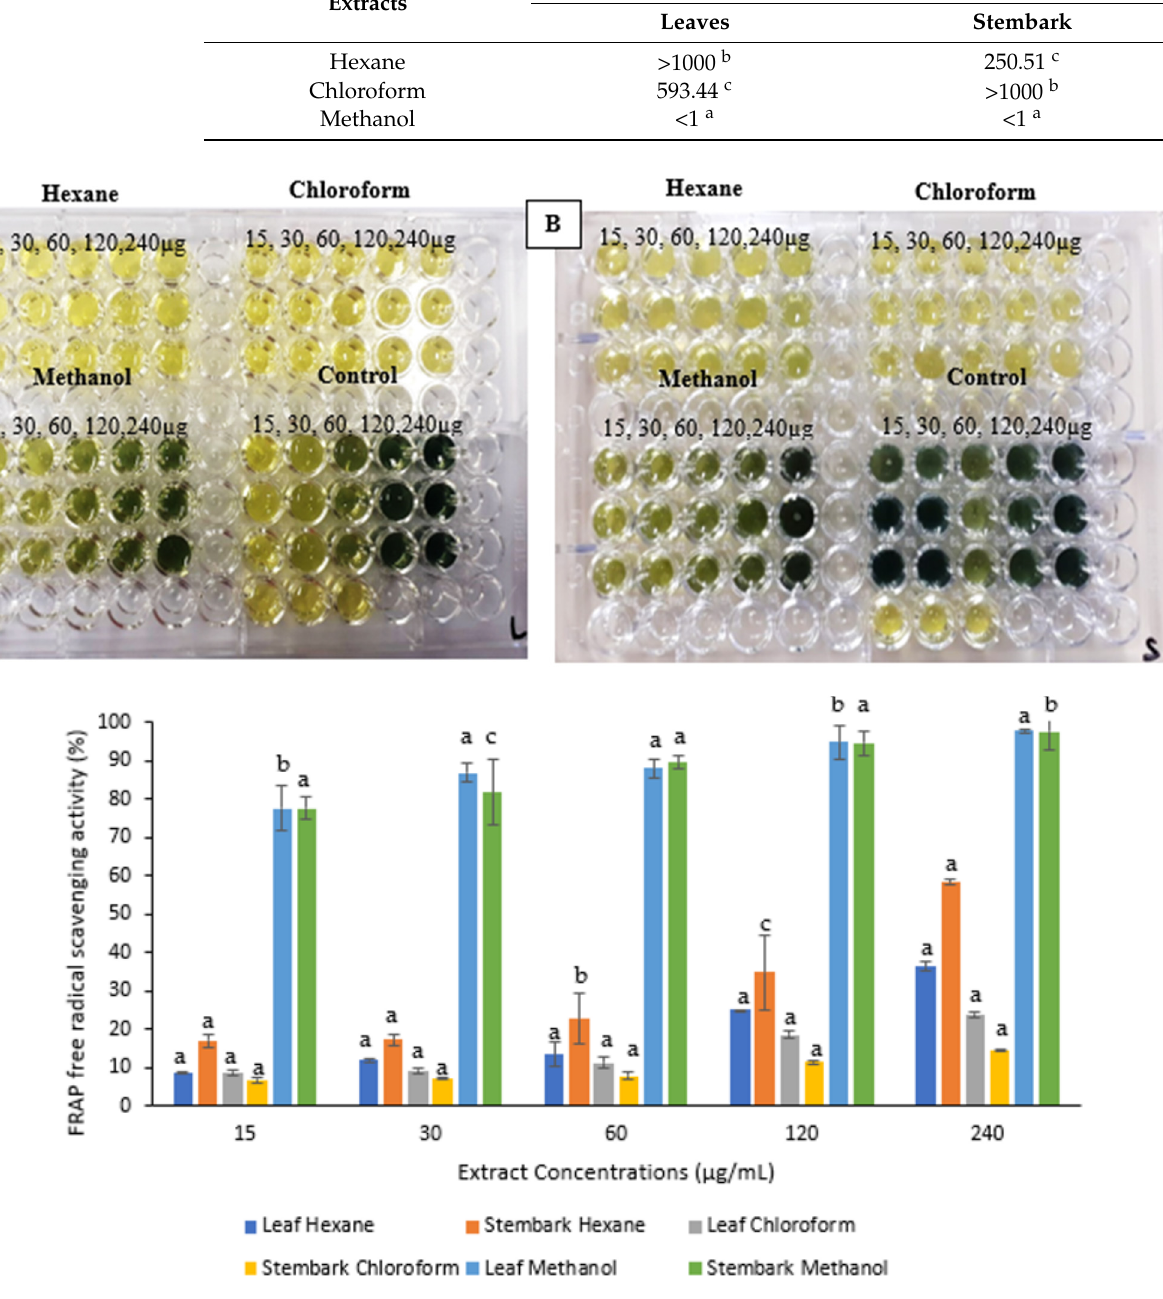
Figure 2. FRAP free radical scavenging activity of the C. erythrophyllum leaf and stembark extracts extracted in hexane, chloroform, and methanol. Microplates with wells containing the reaction mixture and different concentrations of each of the ( A ) leaf and ( B ) stembark extracts. The positive control was gallic acid. ( C ) FRAP free radical scavenging activity (%) compared to the control for each extraction solvent and each leaf or stembark extract concentration. a–c letters above the bars indicate significantly different data (Tukey’s honest significant difference multiple range post hoc test, p < 0.05).